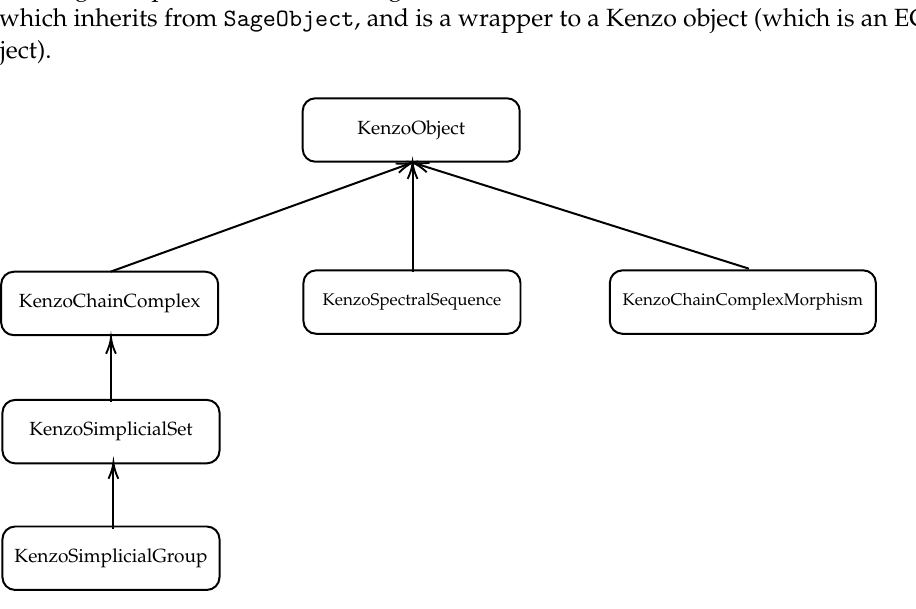
Figure 1. Class diagram of the